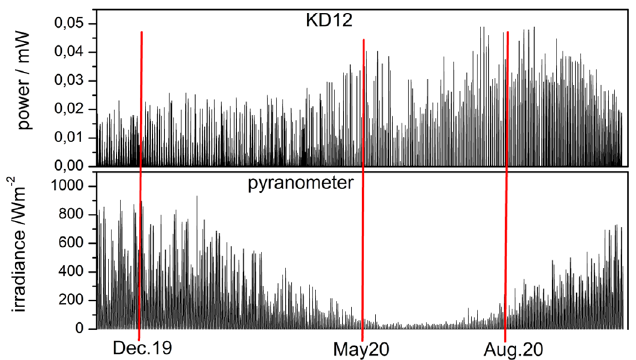
Fig. 3. Irradiance measured by a pyranometer and estimated power for the DSSC panel from November 2019 to